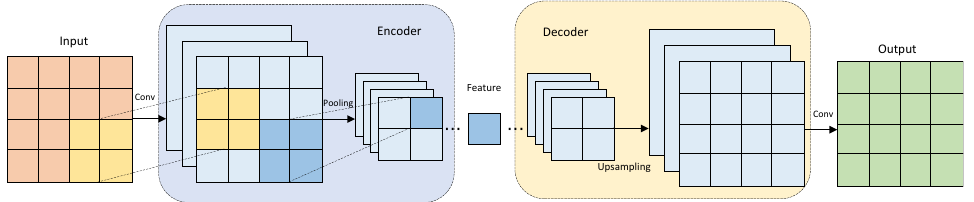
Figure 4. Encoder and decoder. The input data through PConv extracts higher-level spatial features through the encoder and decoder